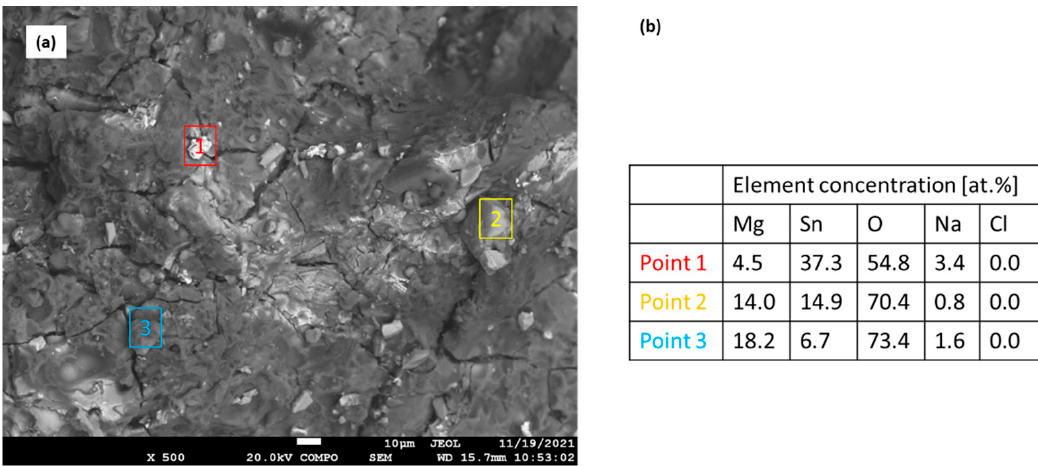
Figure 11. Microstructure ( a ) and chemical composition ( b ) of the corrosion product on the Mg 2 Sn alloy after potentiodynamic polarization in 3.5% NaCl.